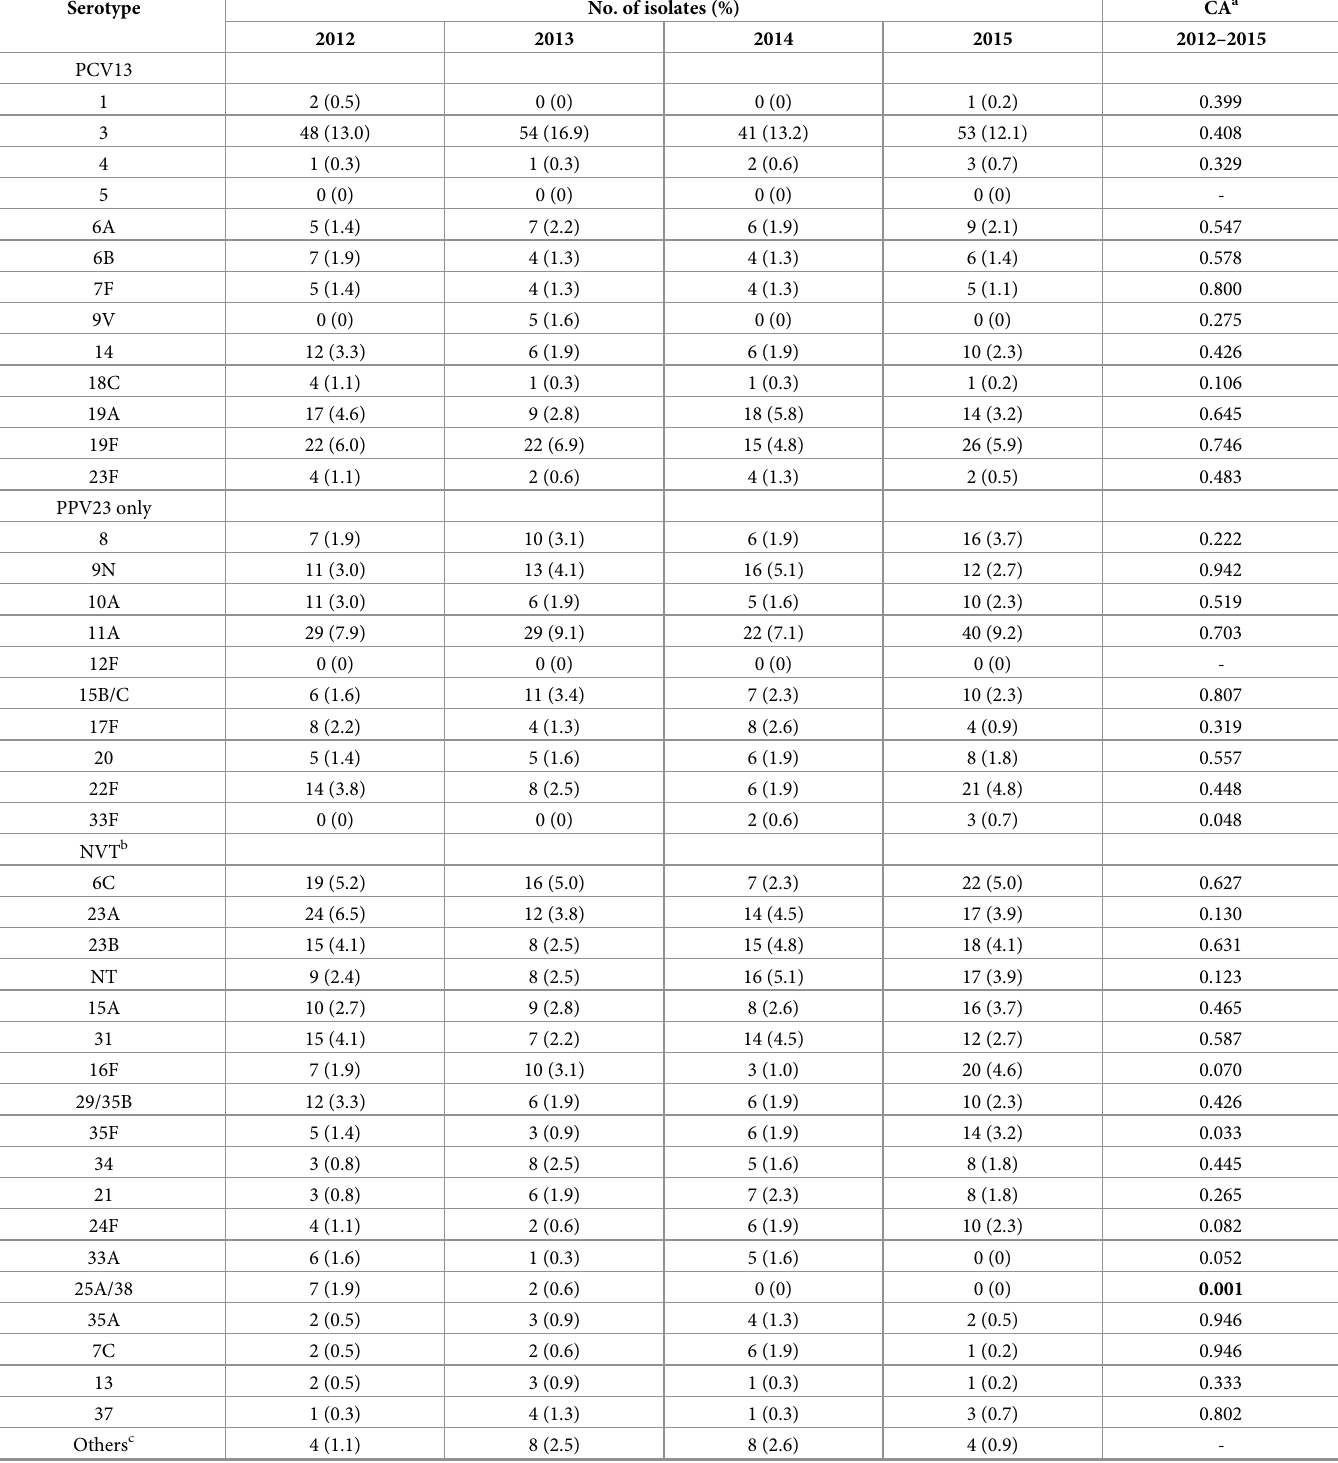
Table 1. Serotypes of the isolates responsible for non-invasive pneumococcal pneumonia in adult patients ( � 18 years), 2012–2015.